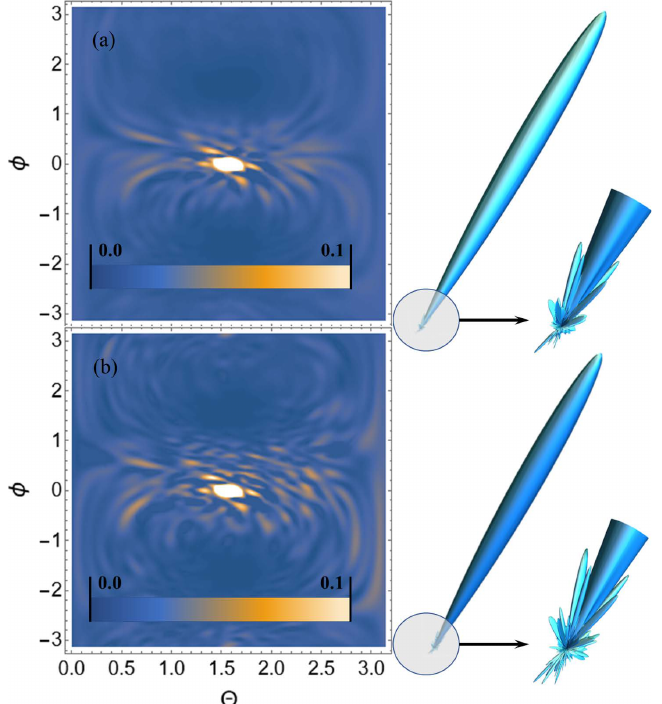
Figure 7. USP scattering spectra on the CCG trinucleotide: ( a ) calculated using Equation (4), ( b ) cal- culated by Equation (1). The spectra are presented as 2D ( left ) and 3D ( right ) plots. The 2D plots are presented in dimensionless units and normalised to the maximum value of the spectrum. The angles φ , θ are spherical angles in the coordinate system shown in Figure